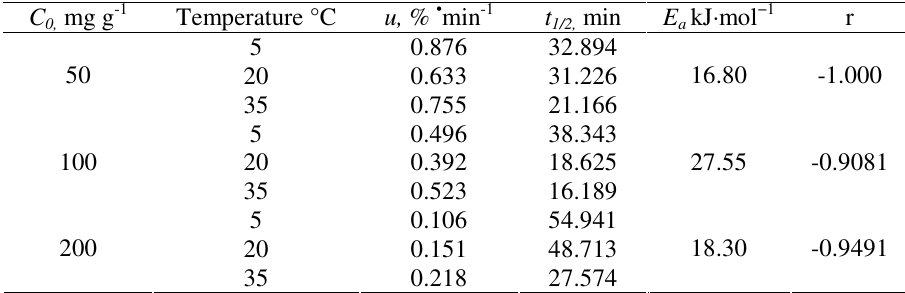
Table 4. Kinetic parameters for the second-order